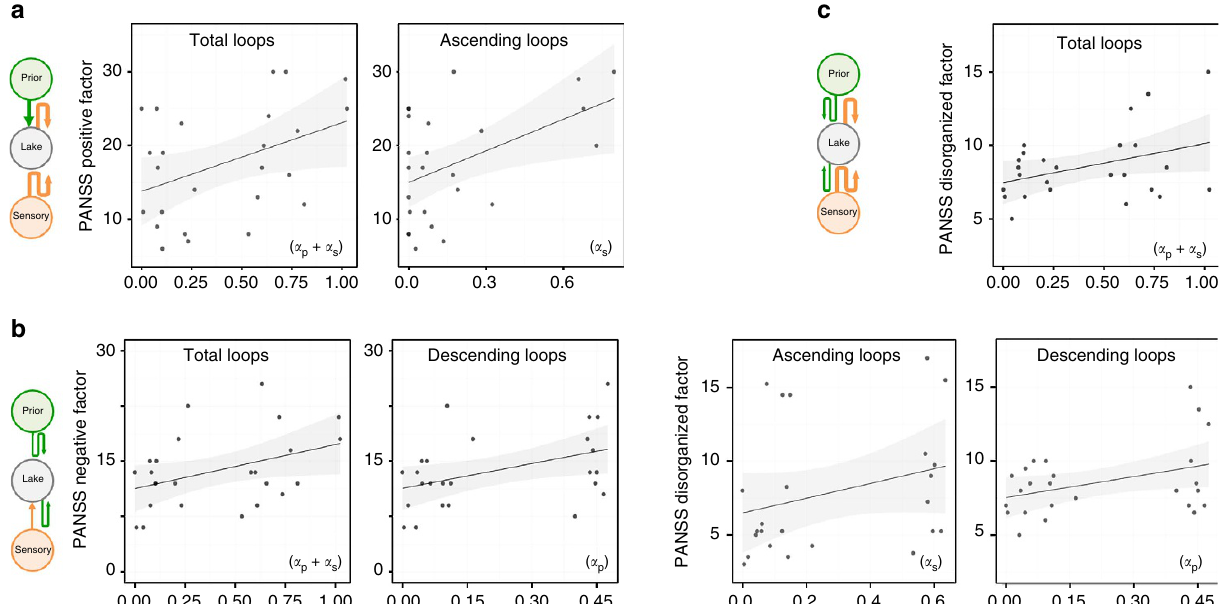
Figure 6 | Correlation analyses between the parameters and the clinical dimensions of SCZ. ( a ) Positive SCZ symptoms, which were measured using the PANSS positive subscale, were correlated with the number of ascending loops ( a s, r ¼ 0.46, P ¼ 0.04) and the total number of loops (loops, r ¼ 0.45, P ¼ 0.05). These results correspond to the over-counting of the sensory evidence (orange arrows in the graph model); ( b ) Negative symptoms, which were measured using the PANSS negative subscale, were correlated with the number of descending loops ( r ¼ 0.51, P ¼ 0.02) and the total number of loops ( r ¼ 0.46, P ¼ 0.04), corresponding to the over-counting of the prior information (green arrows). ( c ) Disorganized symptoms, which were measured using the PANSS disorganized subscale, were correlated with both ascending ( r ¼ 0.48, P ¼ 0.03) and descending ( r ¼ 0.46, P ¼ 0.04) loops, which indicates the global over-counting of the feed-forward and feedback information. Regression lines are plotted with their 95% confidence